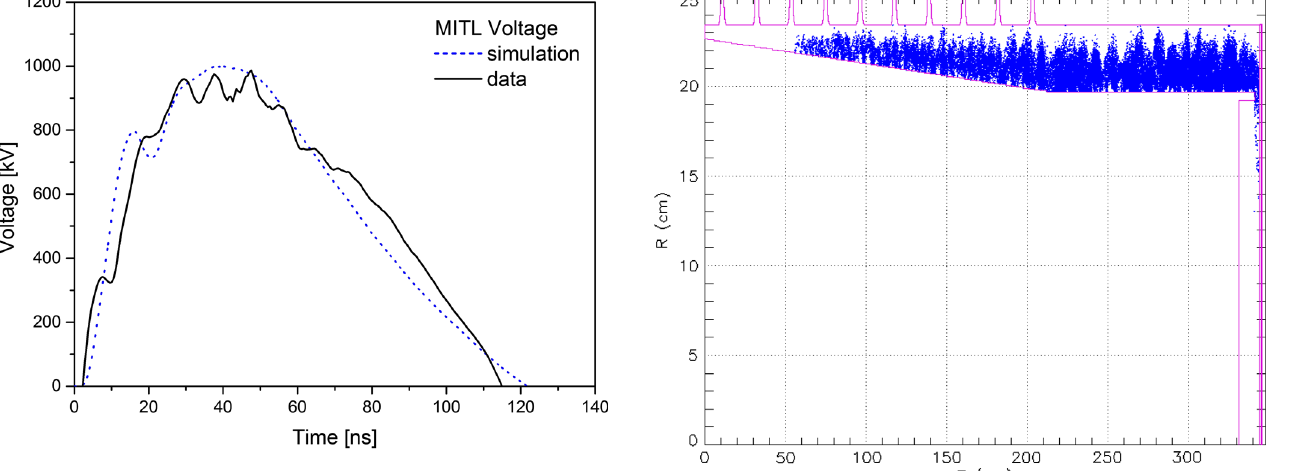
FIG. 6. Comparison of experimental data and simulation results of the MITL voltage after the tenth cavity. FIG. 7. Electron particle (in blue online) plot at maximum